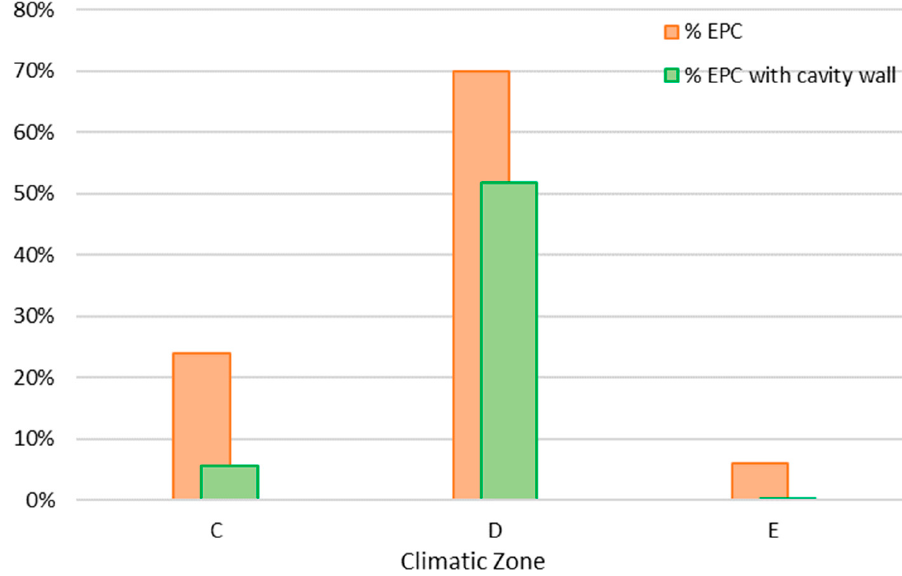
Figure 14. EPC distribution by climatic zone and by wall without cavity and wall with cavity [%].